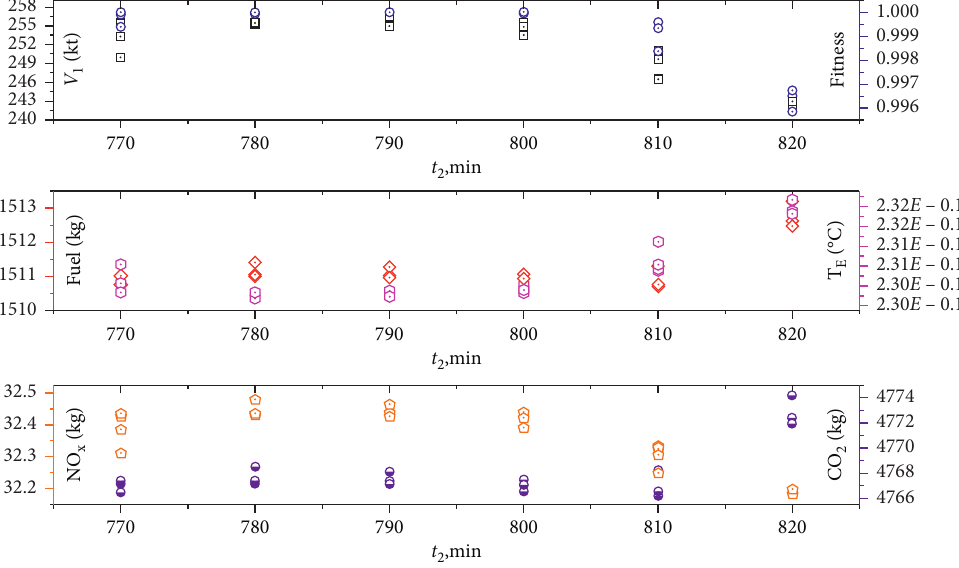
on optimization 2 , min